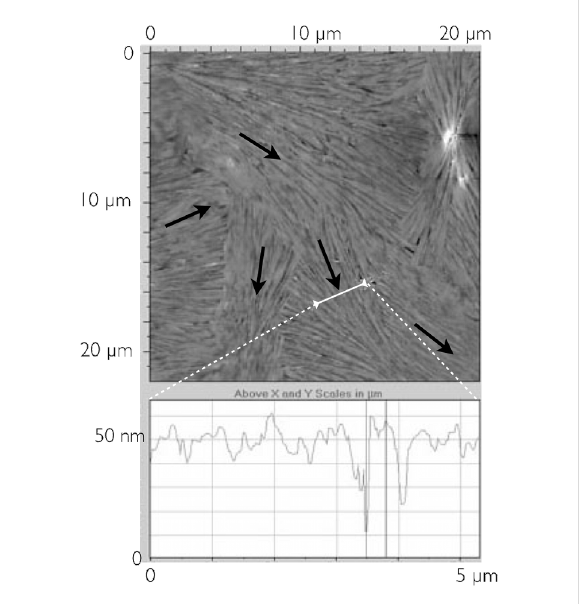
Figure 6: AFM image of a spin-coated sample from a solution of 6 mg/ ml. Below the surface profile along the white arrow shows a presum- able fiber layer thickness of about 40